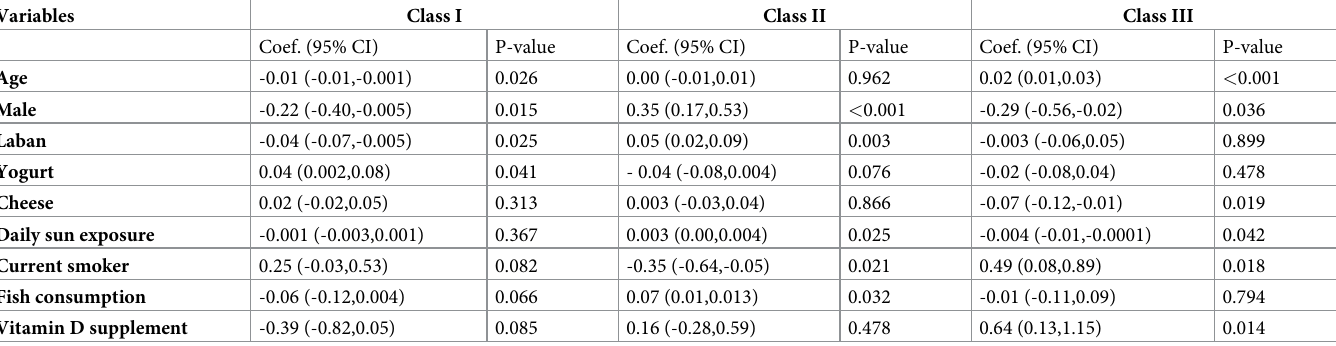
Table 4. Results of logistic regression coefficient of posterior probabilities for each FMM class (n = 2,578).